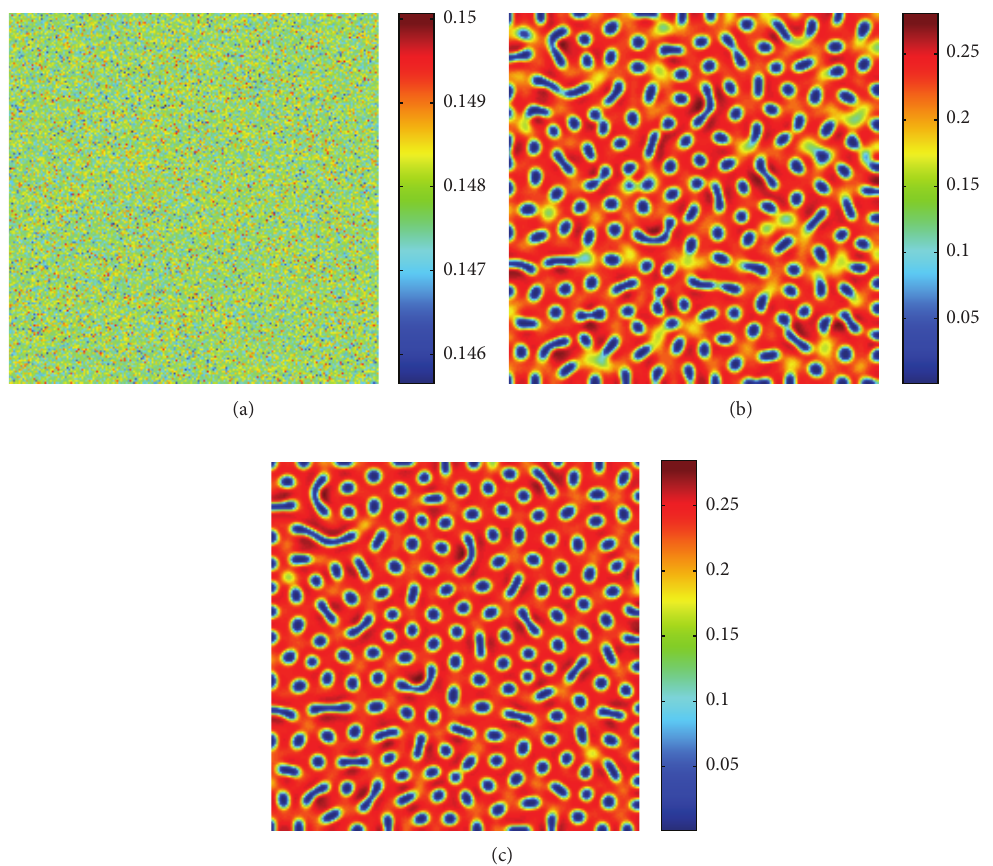
Figure 6: Snapshots of contour diagrams of the time evolution of algae at different points in time with 𝑁 = 0.31, 𝐷 2 = 1.25 . (a) 0 iterations, (b) 50000 iterations, and (c) 100000